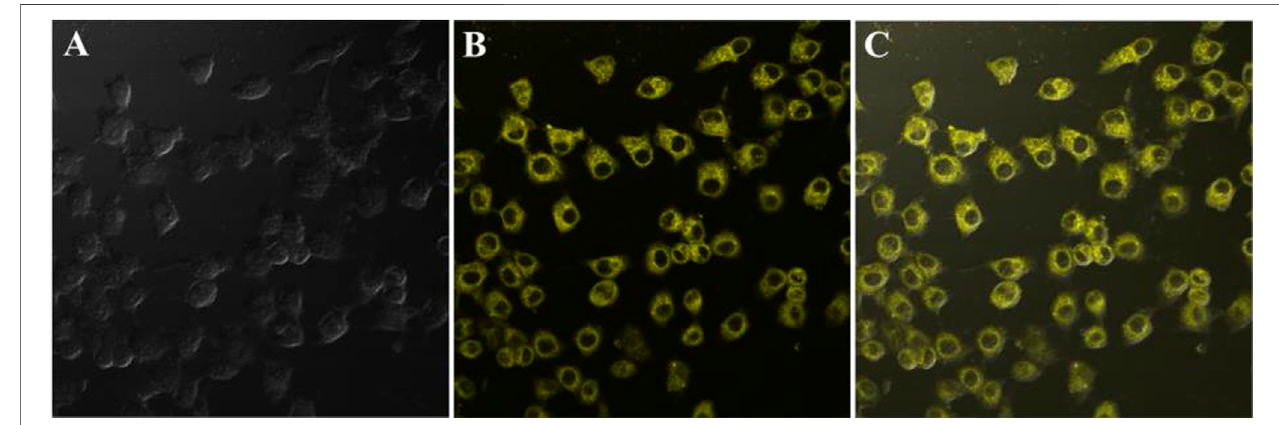
FIGURE 4 | Fluorescence images of HeLa cells incubated with rhodanine derivative 1 (20 μ M) for 30 min at 37 ° C; from left to right are bright fi eld image (A) , fl uorescence image (B), and merge image (C) .